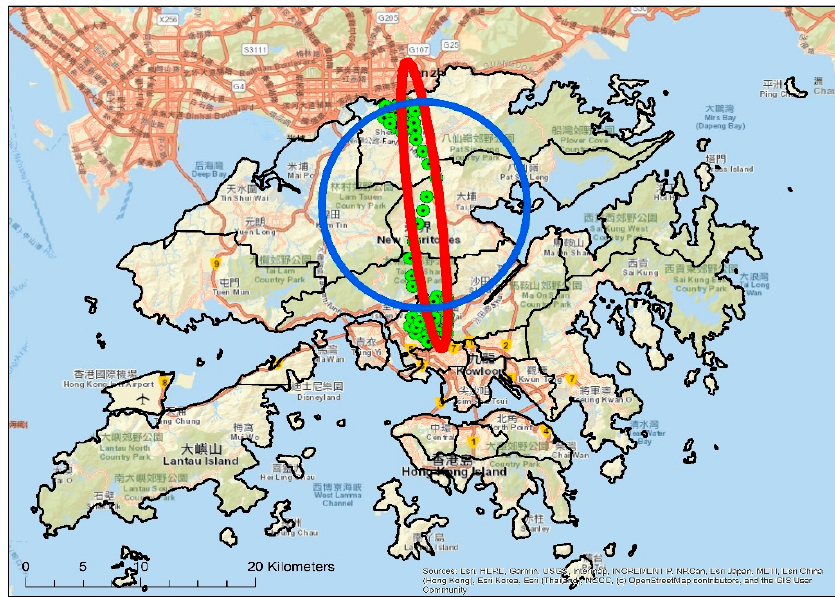
Figure 1. Example of SDE (red) and standard distance (blue).